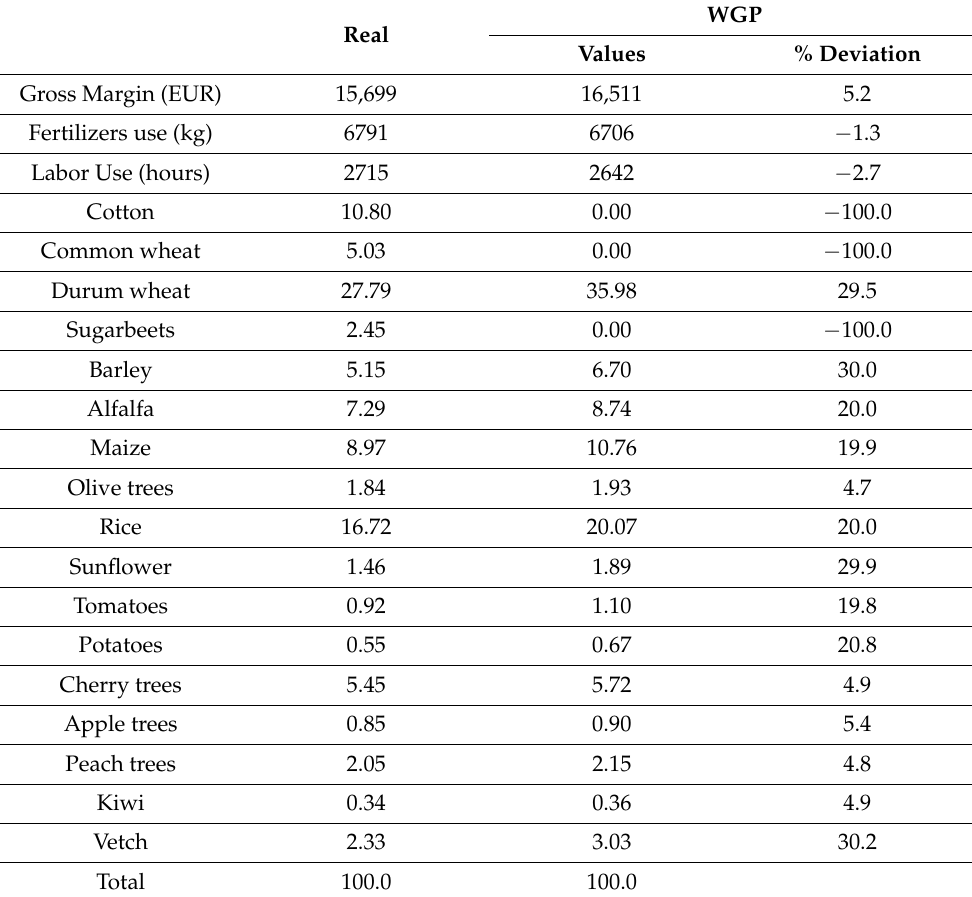
Table 4. Comparison of the Real situation crop plan vs. WGP model optimum crop plan. Source: Our